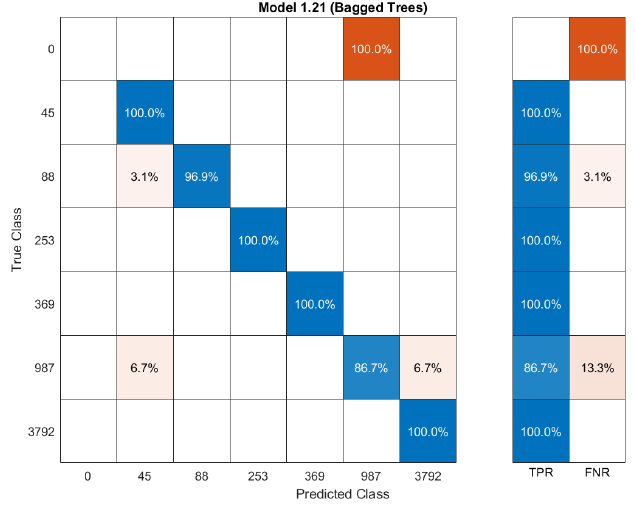
Figure 10. Framework bit rate prediction